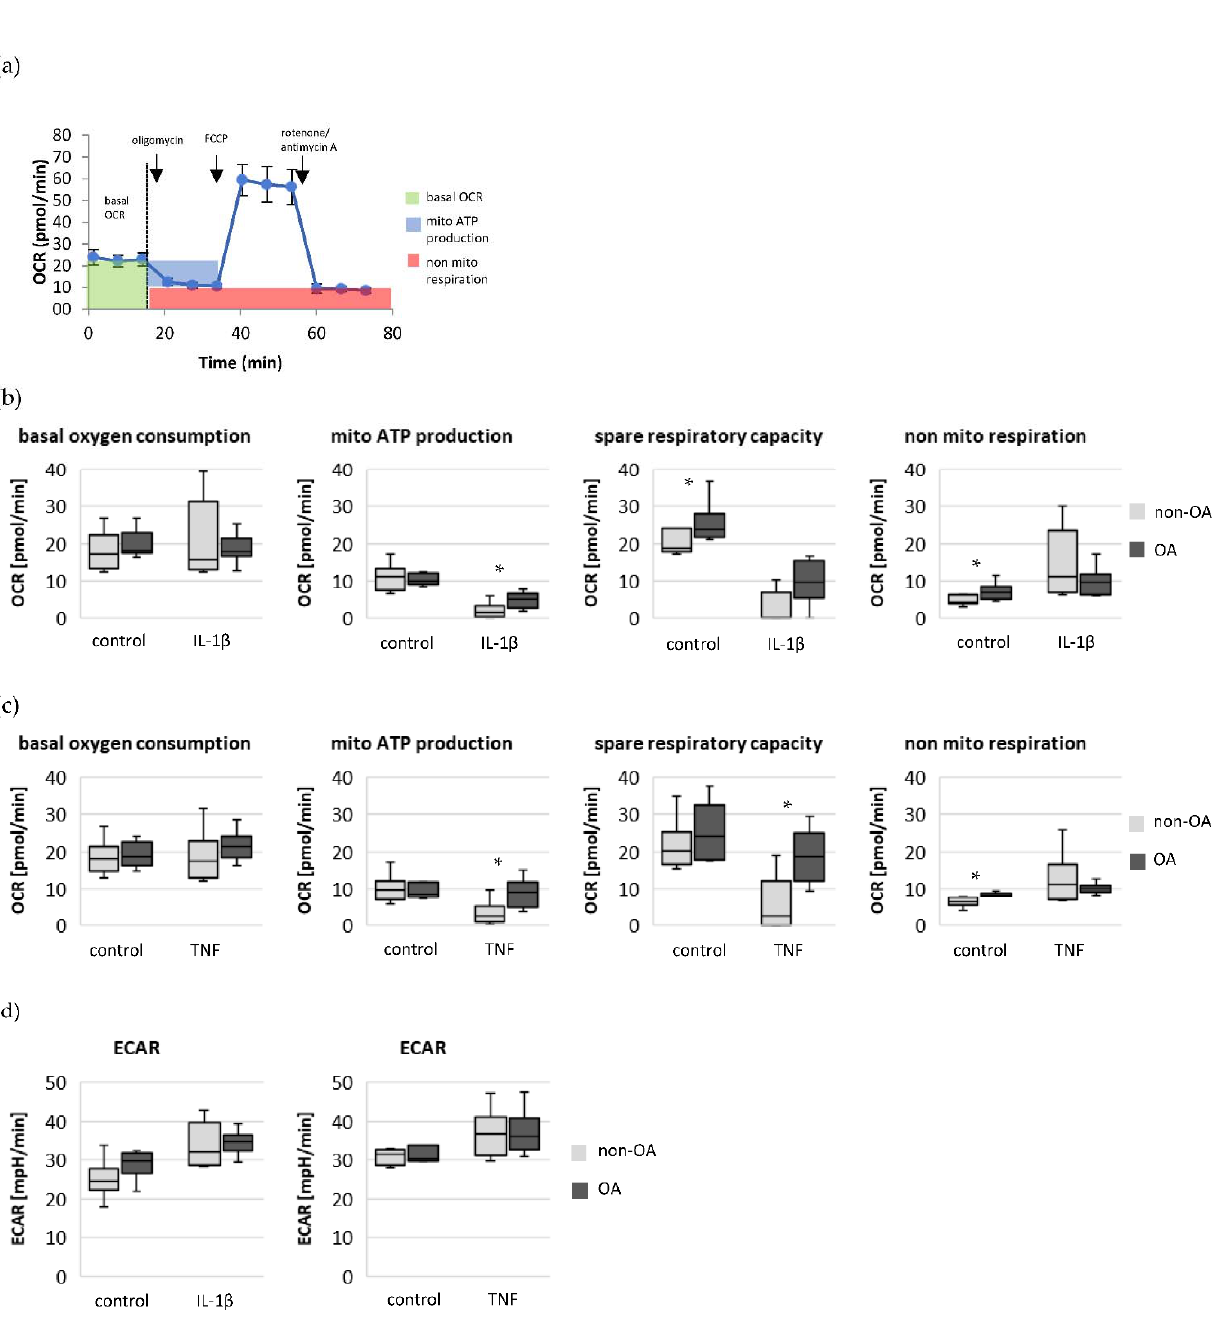
Figure 2. Basal oxygen consumption rate, mitochondrial ATP production, spare respiratory capacity, non-mitochondrial respiration and ECAR of non-OA and OA chondrocytes. ( a ) Schema of the OCR measurement with application of oligomycin, FCCP and rotenone + antimycin A. ( b ) OCR values of unstimulated (control) and IL-1 β -stimulated cells (non-OA patients = 6, OA patients = 7). ( c ) OCR values of unstimulated (control) and TNF-stimulated cells (non-OA patients = 6, OA patients = 6). ( d ) Comparison of ECAR values of unstimulated (control), IL-1 β -stimulated (non-OA patients = 6, OA patients = 7) and TNF-stimulated cells (non-OA patients = 6, OA patients = 6). Statistics: non-OA vs. OA chondrocytes, Mann–Whitney U -test. Values are displayed as box plots. * p < 0.05. OCR: oxygen consumption rate; mito: mitochondrial; ECAR: extracellular acidification rate.